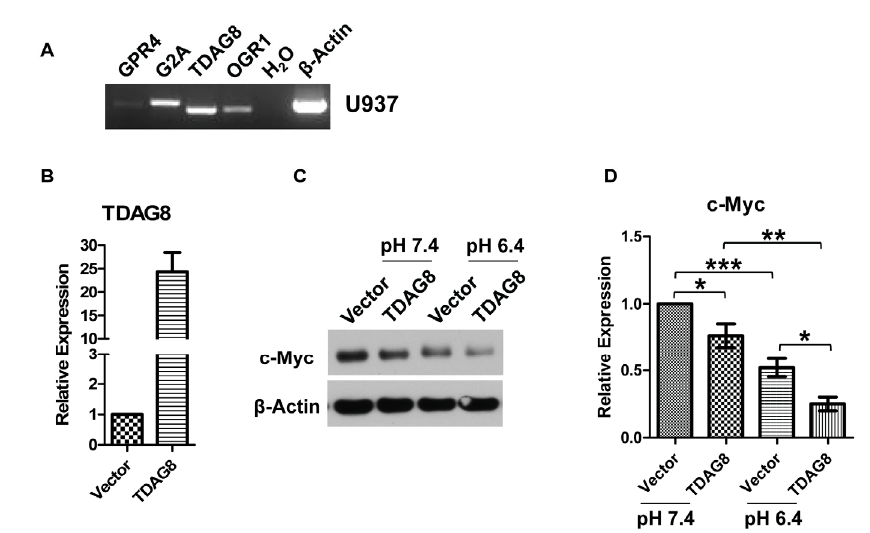
Figure 3. The expression of c-Myc protein is decreased by TDAG8 overexpression and increased by TDAG8 knockdown in U937 cells. ( A ) TDAG8 is highly expressed in U937 cells. Total RNA was isolated from U937 cells and subject to RT-PCR using gene-specific primers of GPR4, G2A, TDAG8 and OGR1. β -Actin was used as a positive control; ( B ) Real-time RT-PCR detecting TDAG8 expression in U937/vector and U937/TDAG8 cells; ( C ) U937/vector and U937/TDAG8 cells were treated with HEM-buffered RPMI (Roswell Park Memorial Institute) medium at pH7.4 or pH 6.4 for 3 h and then subject to Western blot using anti-c-Myc antibody. β -Actin was used as a loading control; ( D ) Quantification of Western blot results. The expression of c-Myc in U937/vector cells under the three-hour pH 7.4 treatment was set as one; ( E ) Real-time RT-PCR of TDAG8 in U937/scramble-shRNA and U937/TDAG8-shRNA cells; ( F ) U937/scramble-shRNA and U937/TDAG8-shRNA cells were treated with HEM-buffered RPMI medium at pH7.4 or pH 6.4 for 3 h and, then, subject to Western blot using anti-c-Myc antibody. β -Actin was used as a loading control; ( G ) Quantification of Western blot results. The expression of c-Myc in U937/scramble-shRNA cells under the pH 7.4 treatment was set as one. The quantification of Western blot data was derived from at least five biological replicates. Error bars indicate ±SEM. * p < 0.05; ** p < 0.01; *** p <